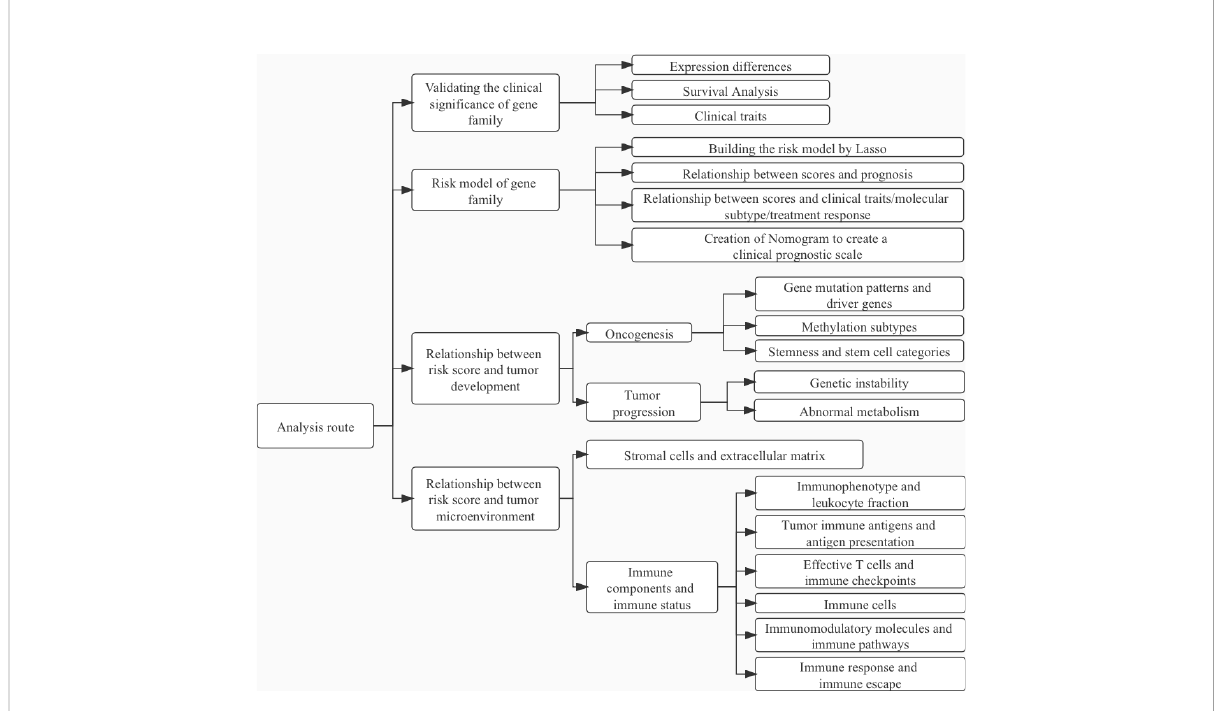
FIGURE 1 Article Analysis Flow